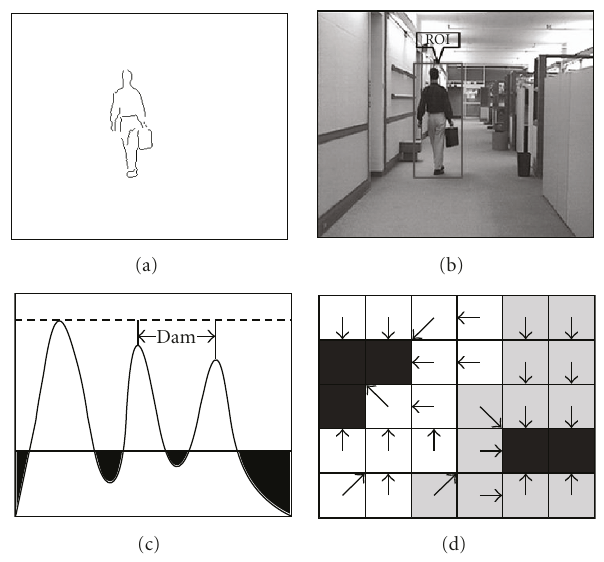
Figure 6: ROI detection and segmentation. (a) Moving edges; (b) ROI ; (c) gray-level topographic surface; (d) flooding process and dam